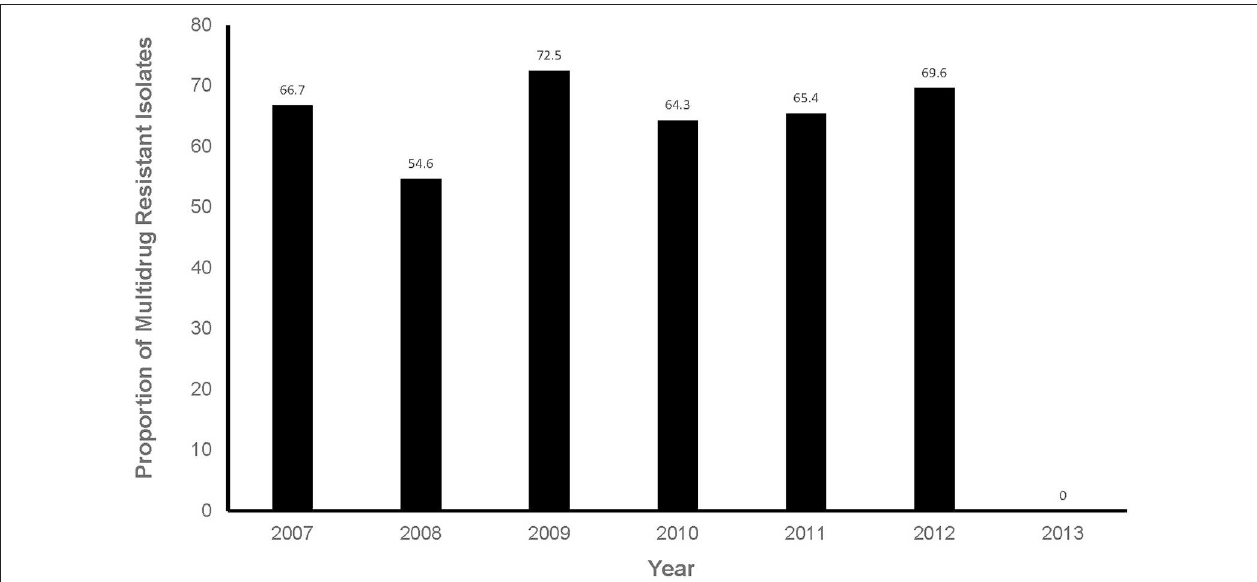
FIGURE 5 | Proportions of multidrug resistant isolates from respiratory infection cases presented at a referral veterinary teaching laboratory in South Africa, 2007-2013.